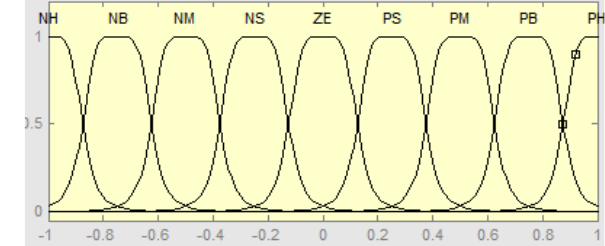
Figure 9. Membership functions of the input variables FLREM